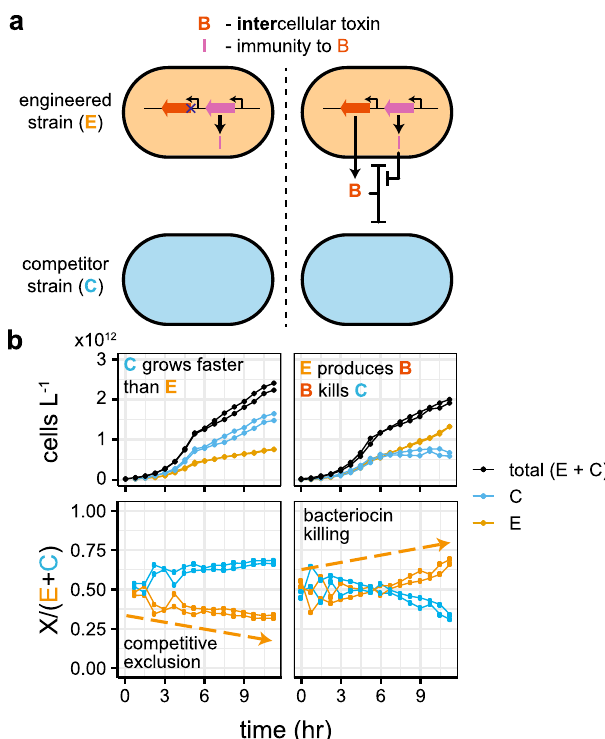
Fig. 1 Bacteriocins can overcome competitive exclusion. a The engineered strain with inactivated cvaC gene produces no bacteriocin. With an intact gene, the strain secretes a bacteriocin, which kills the competing strain. b Co-cultures of the engineered and competitor strain were grown in a microtitre plate. With mutationally inactivated bacteriocin, the faster- growing competitor excludes the engineered strain. Bacteriocin secretion leads to the killing of the competitor and domination by the engineered strain. Each panel includes two replicates, with each point showing the value of individual replicates calculated from plate reader measurements.